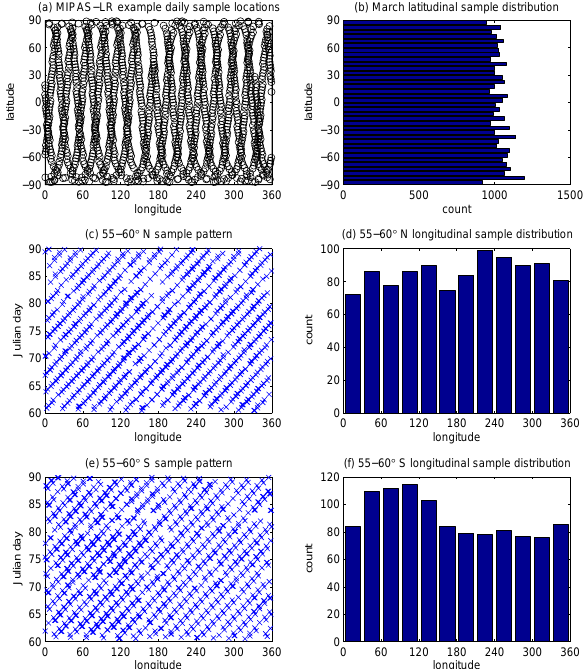
Fig. 3. ACE-FTS sampling in March 2005. (a) Full monthly sam- pling spatial pattern, (b) monthly sample counts per 5 ◦ latitude bin, (c) time, longitude pattern of samples and (d) zonal sample distri- bution for the 55–60 ◦ N latitude bin, (e) time, longitude pattern of samples and (f) zonal sample distribution for the 55–60 ◦ S latitude